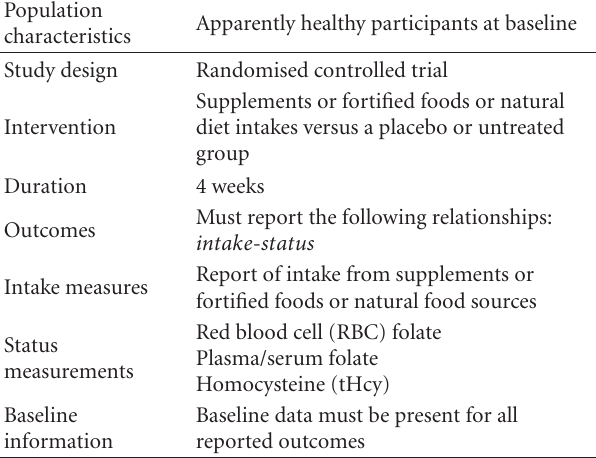
Table 1: Inclusion criteria followed to select potentially relevant papers for data